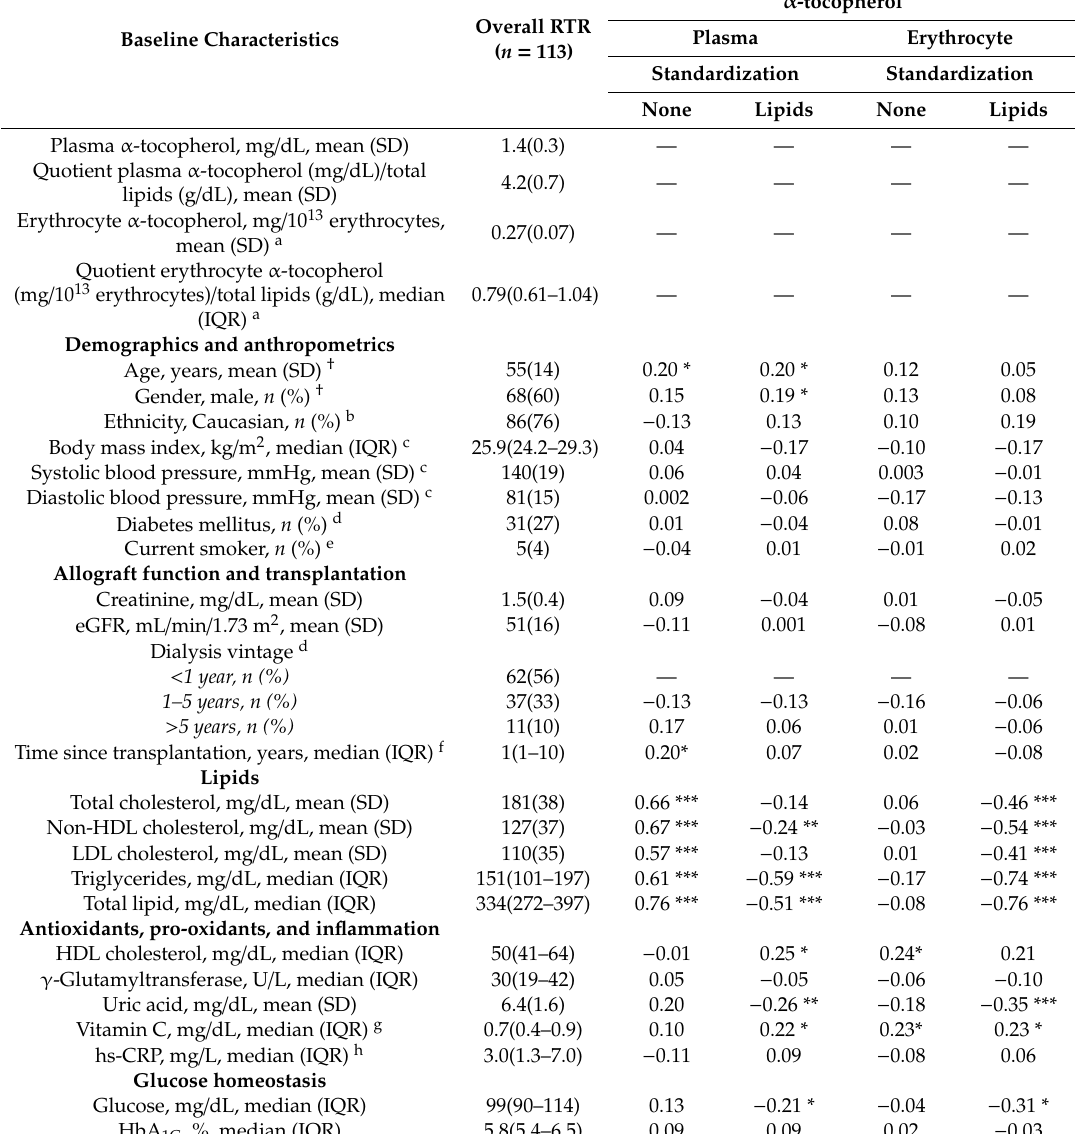
Table 3. Baseline characteristics of renal transplant recipients, and their associations with non-standardized and total lipids-standardized plasma and erythrocyte α -tocopherol concentrations.